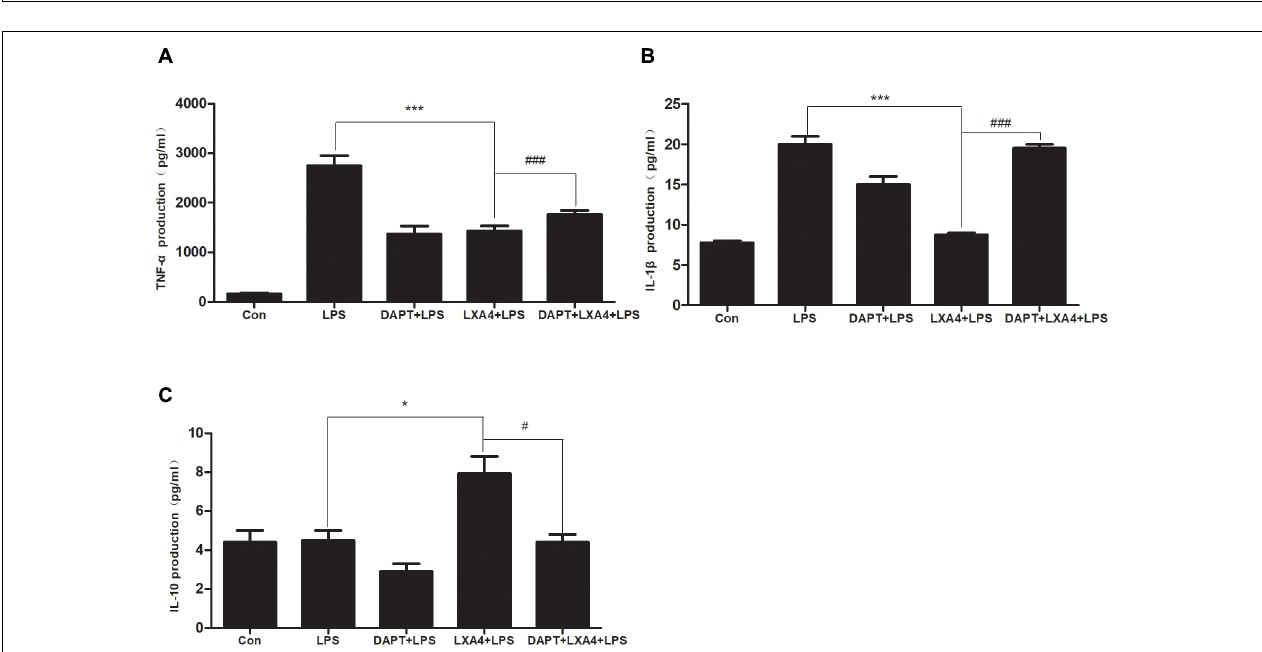
FIGURE 11 | Western blot analysis of the Notch1, Hes1, Hes5, iNOS and Arg1 effect after DAPT pretreatment. (A–C) Western blot analysis of the protein level of iNOS, Arg1 in microglia. (A,D–F) Western blot analysis of the protein level of Notch1, Hes1, Hes5 in microglia. # , ∗ p < 0.05; ## , ∗∗ p < 0.01; ### , ∗∗∗ p < 0.001; n.s., no significance.